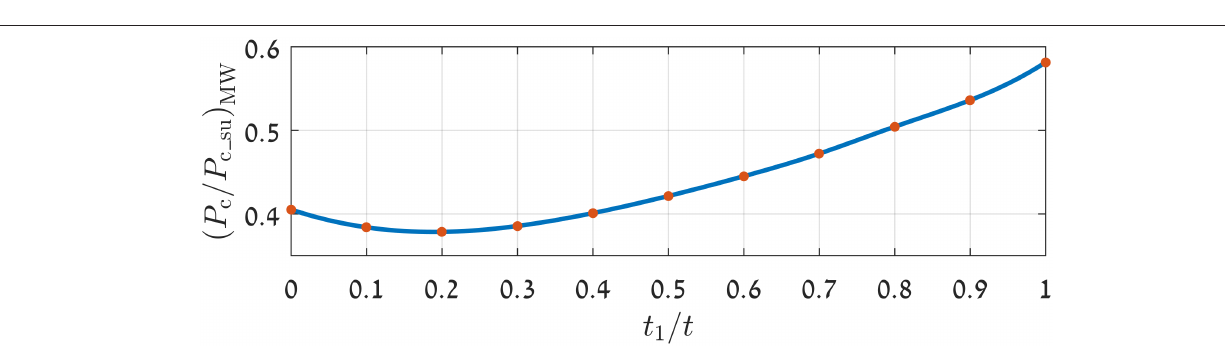
Frontiers in Mechanical Engineering |